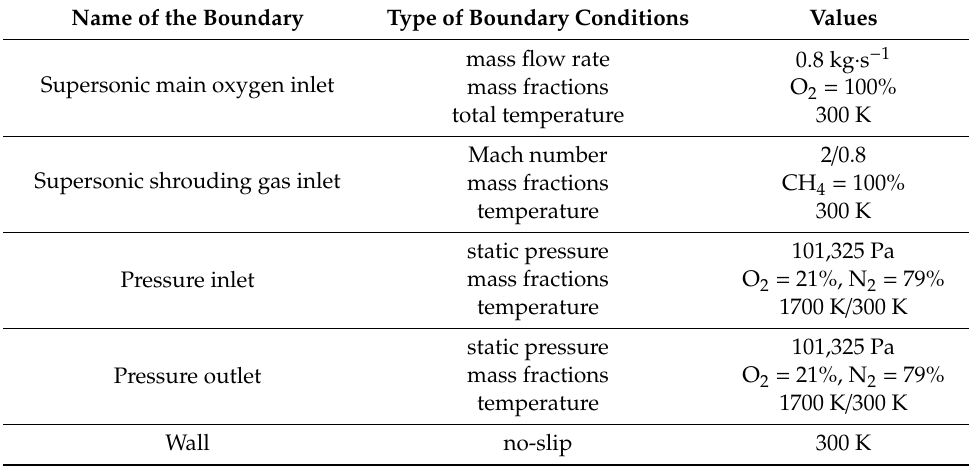
Table 1. Boundary conditions.